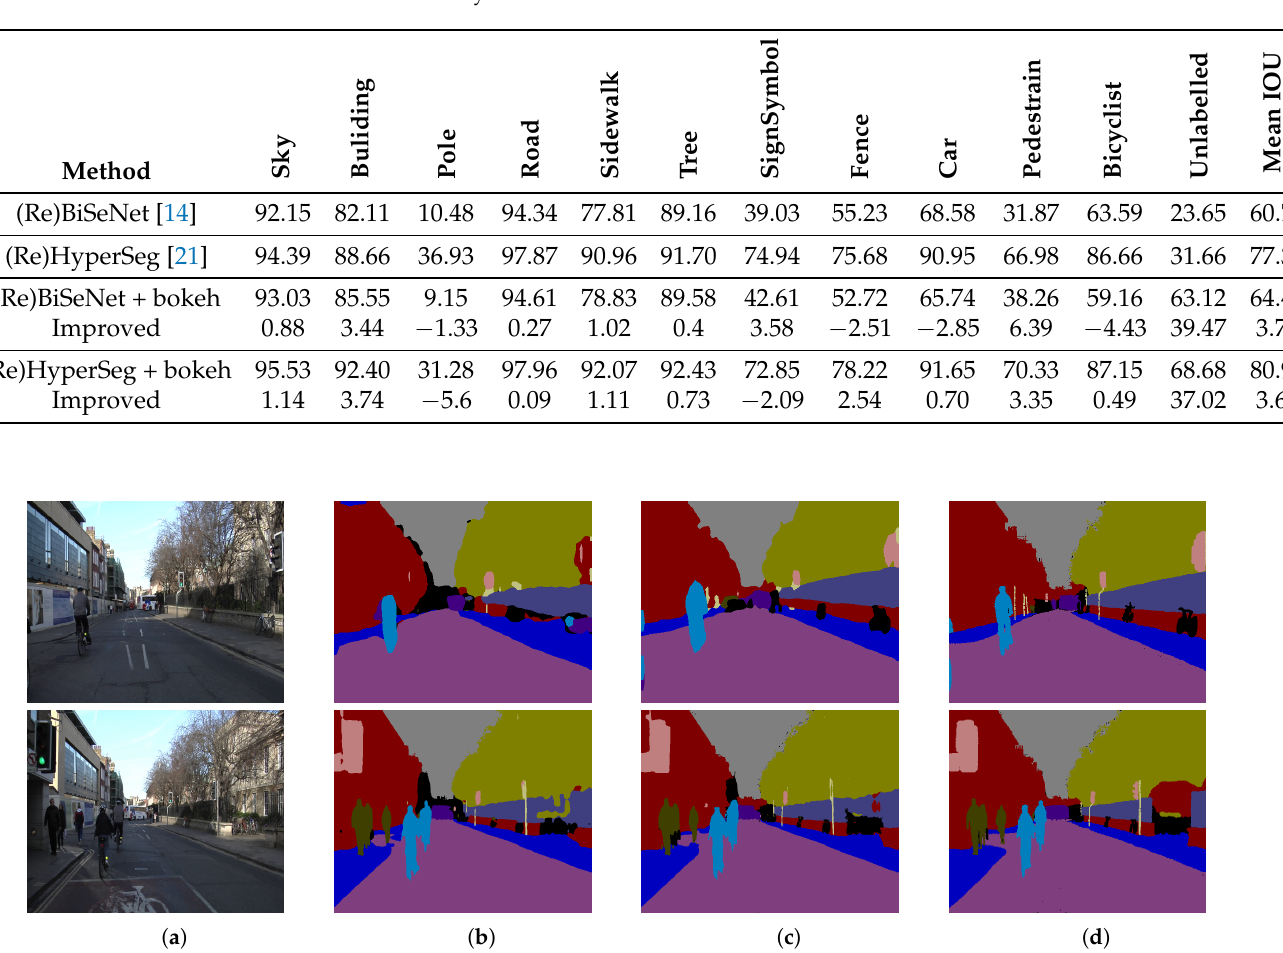
Table 8. Accuracy result on the CamVid val dataset.